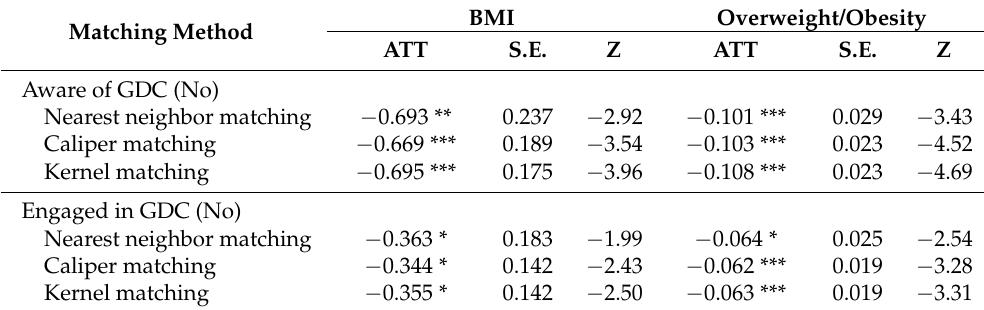
Table 4. PSM results of the influence of GDC on children’s BMI and